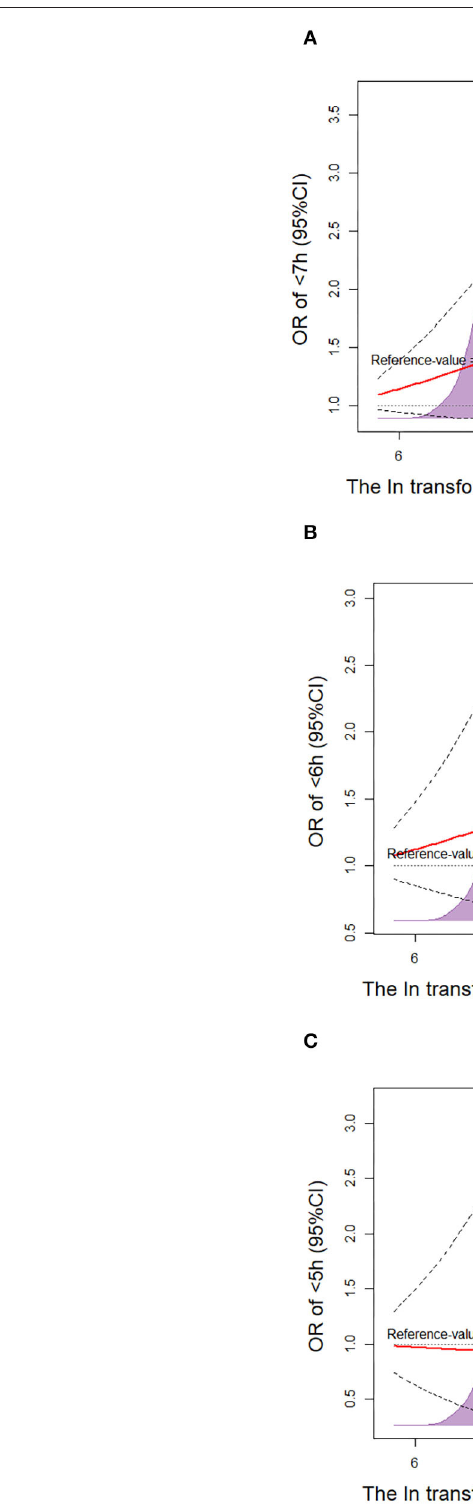
Frontiers in Nutrition |